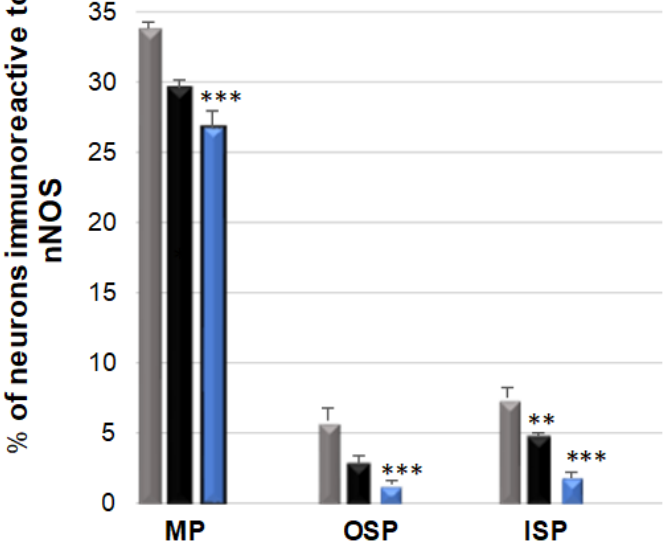
Figure 5. Bar graph showing the percentage variation in the number of neuronal isoform of nitric oxide synthase (nNOS)—immunoreactive neurons as a result of a low (black bar) and a high (blue bar) dose of acrylamide supplementation in the porcine jejunum enteric plexuses. Control pigs (grey bar), MP—the myenteric plexus; OSP—the outer submucosal plexus; ISP—the inner submucosal plexus. ** p < 0.01, *** p < 0.001 point to differences in the expression of exact substance studied with reference to the control pigs.